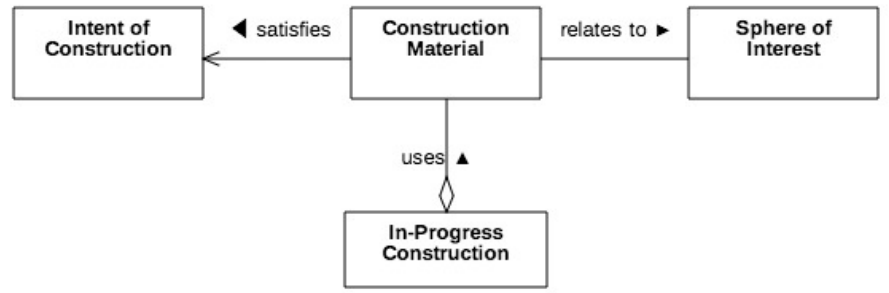
Figure 7. Construction Material in Context. Construction Material comprises information objects that are deemed relevant and potentially useful in constructing the past. Thus, they must relate to the Sphere of Interest and should satisfy the Intent of Construction. Relevant Construction Material is used in In-Progress Construction.